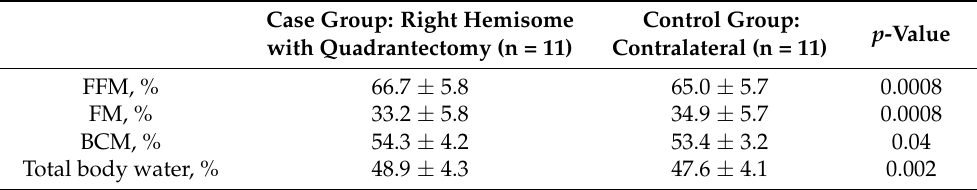
Table 3. Body composition «of side» in patients with quadrantectomy vs. contralateral. Case Group: Right Hemisome Control Group: p -Value with Quadrantectomy (n = 11) Contralateral (n = 11) FFM, % 66.7 ± 5.8 65.0 ± 5.7 0.0008 FM, % 33.2 ± 5.8 34.9 ± 5.7 0.0008 BCM, % 54.3 ± 4.2 53.4 ± 3.2 0.04 Total body water, % 48.9 ± 4.3 47.6 ± 4.1 0.002